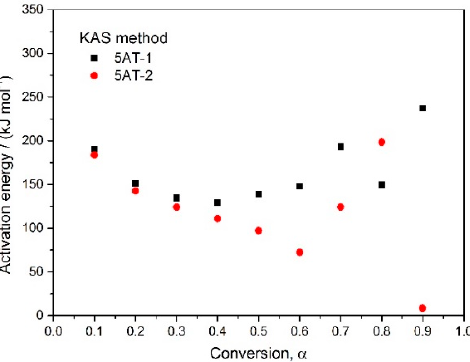
Figure 6. Comparison for E vs. α between 5AT–1 and 5AT–2 obtained using KAS method.